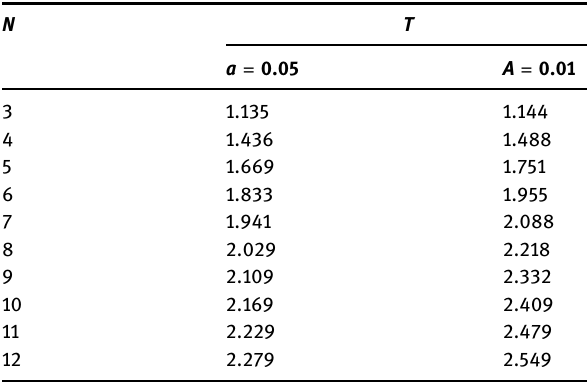
Table 1: Critical value of Grabus criterion ( 1